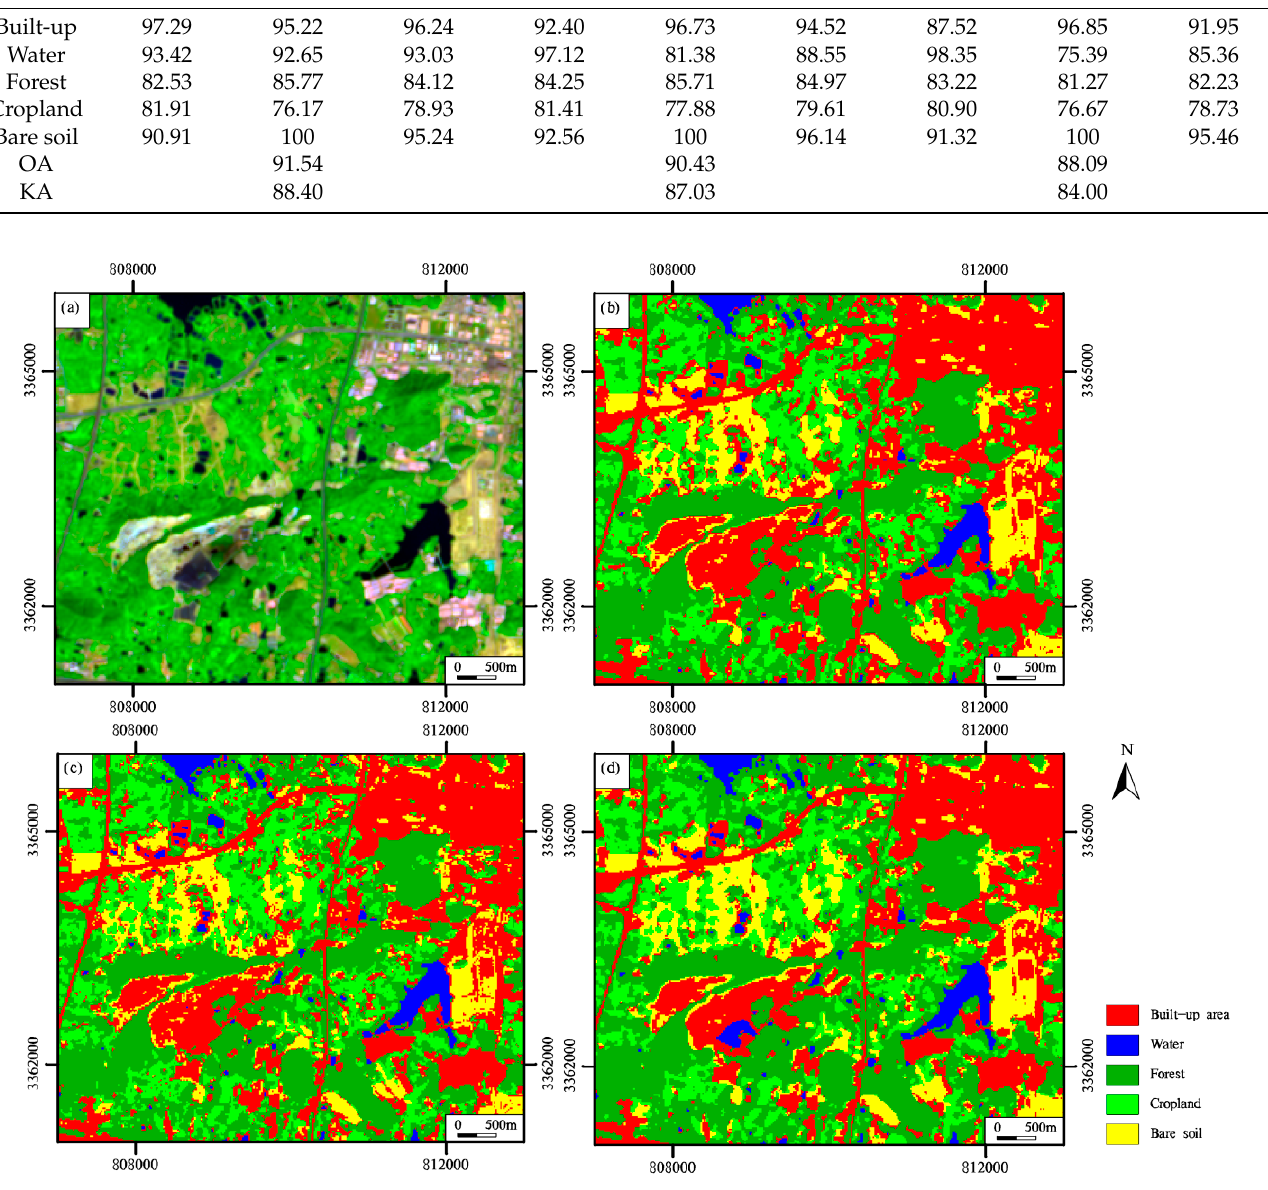
Figure 8. ( a ) False-color composite (red, band 12; green, band 8a; blue, band 2) Sentinel-2B MSI image in Area 1. Land cover classification results using Sentinel-2B MSI image alone with the SVM-CK algorithm ( b ), the SVM algorithm ( c ), and the KELM-CK algorithm ( d